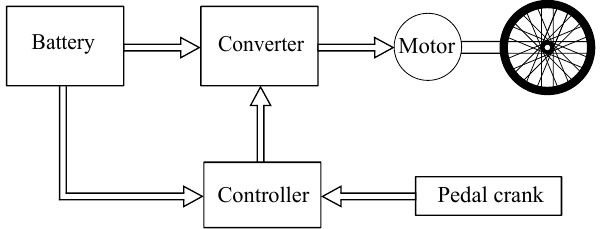
Figure 2. Block-scheme of the e-bike